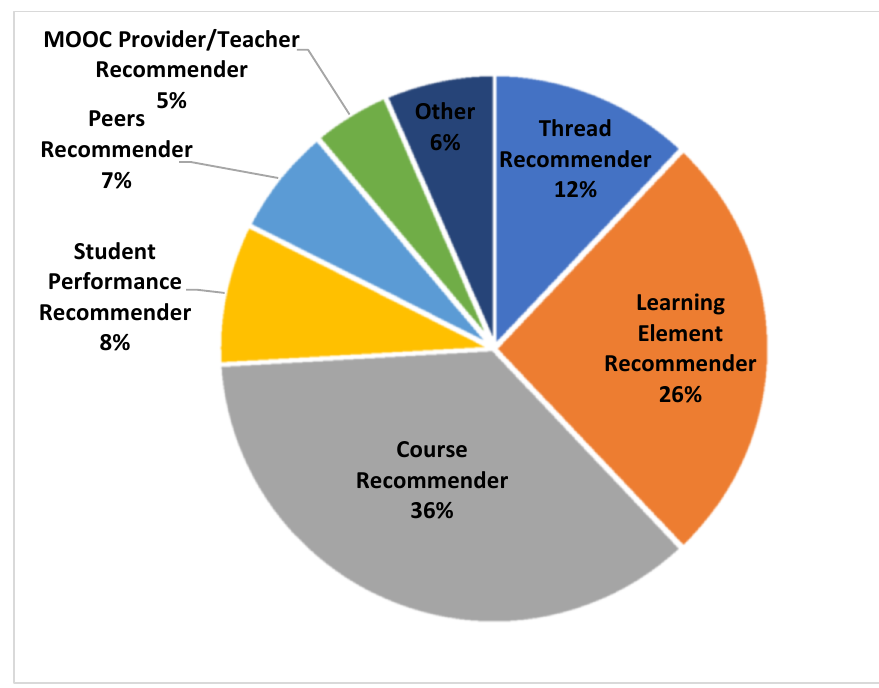
Figure 5. Distribution of work done on different types of recommender systems in MOOCs. To analyze the type and trends of work found in the literature, we grouped the research work with respect to the area of MOOCs where the recommender system is applied. Table 4 shows a detailed categorization of different areas of MOOCs where recommender systems have been applied.